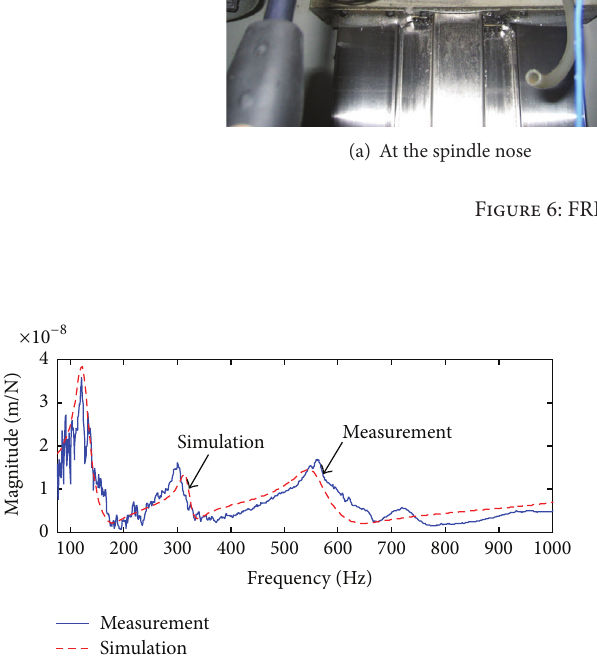
Figure 7: Comparison of the FRF at the spindle nose between sim- ulation and measurement.